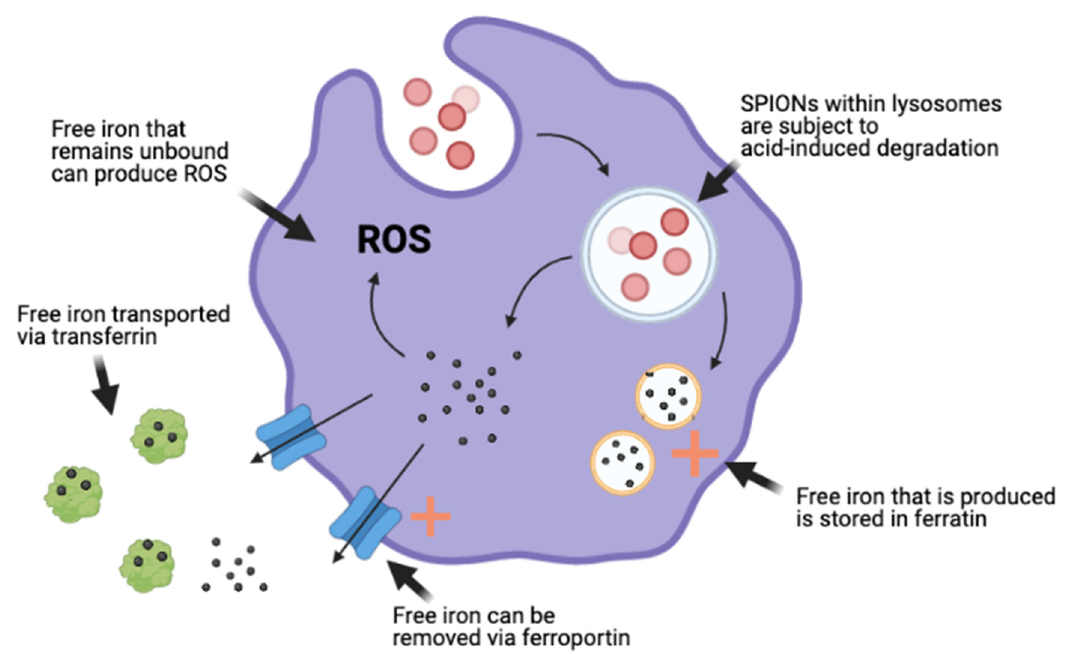
Figure 5. Schematic illustration of the cellular adaptive mechanisms to account for increased free iron produced from SPION degradation, which are upregulated ferratin and ferroportin (indicated by + sign). Diagram also highlights the production of ROS by unbound excess iron.